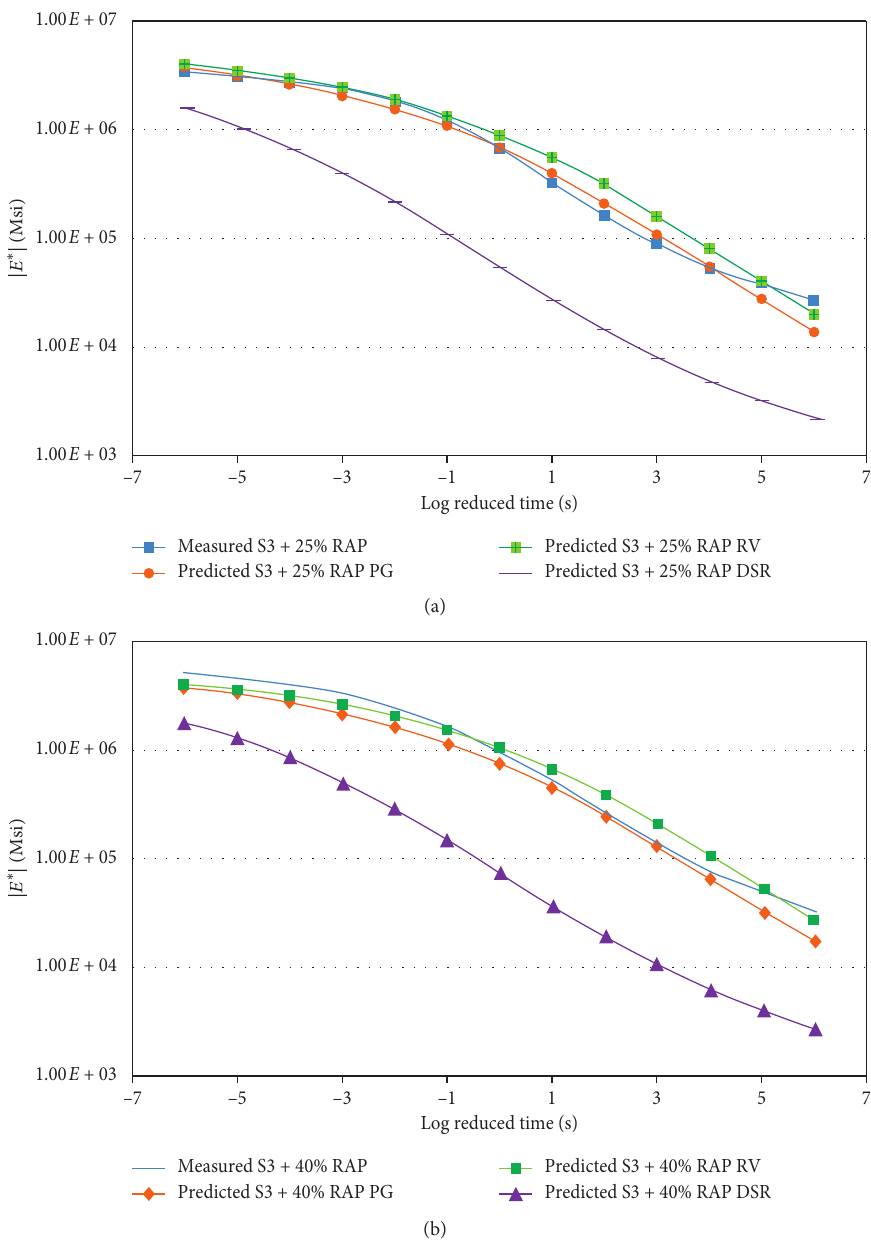
Figure 6: E ∗ master curves for S3 mixes: (a) S3+25% RAP and (b) S3 +40%